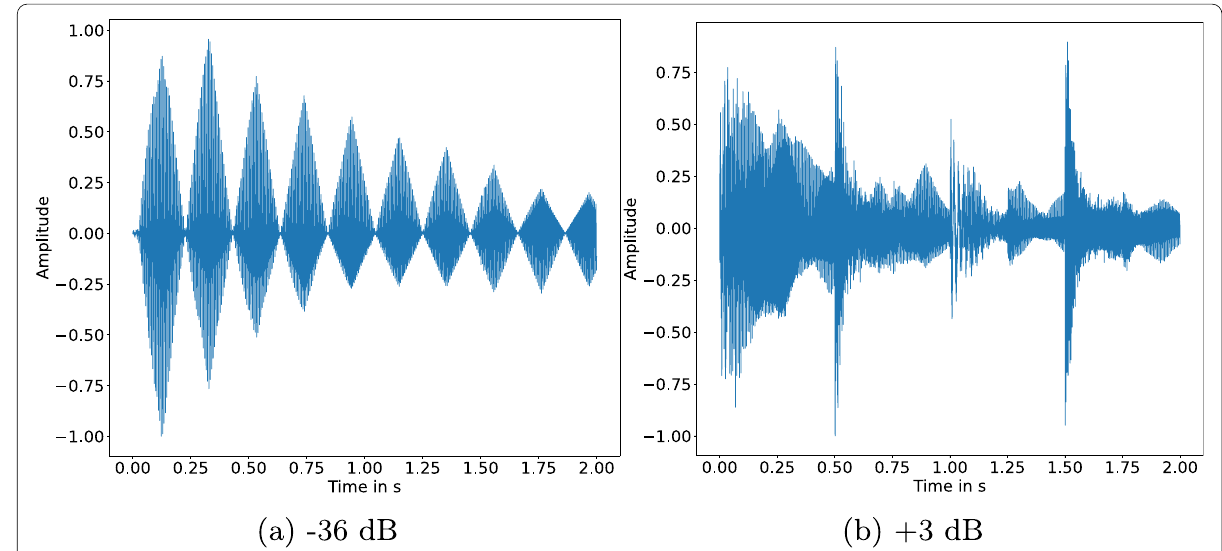
Fig. 2 Audio sample with tremolo on the guitar at a lowest ( peaks in b are due to the snare hits. Modulation depth of the tremolo effect was 1.0, and modulation frequency was